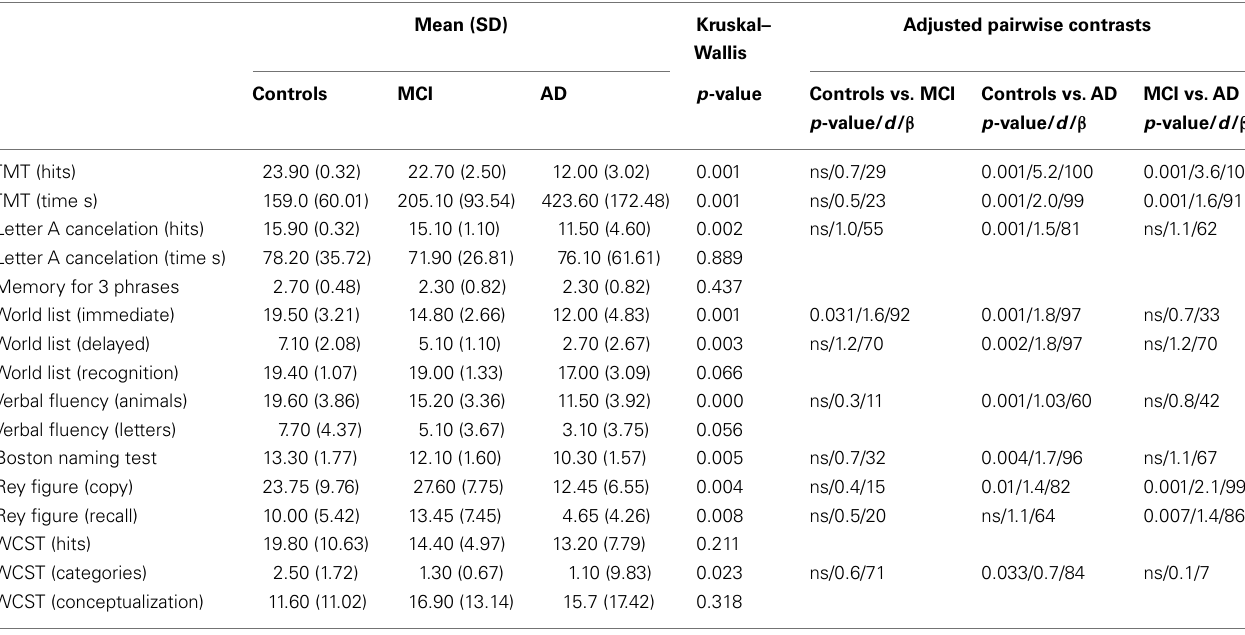
Table 2 | Performance of the three groups on the neuropsychological battery and results of the statistical analysis. Mean (SD) Kruskal–